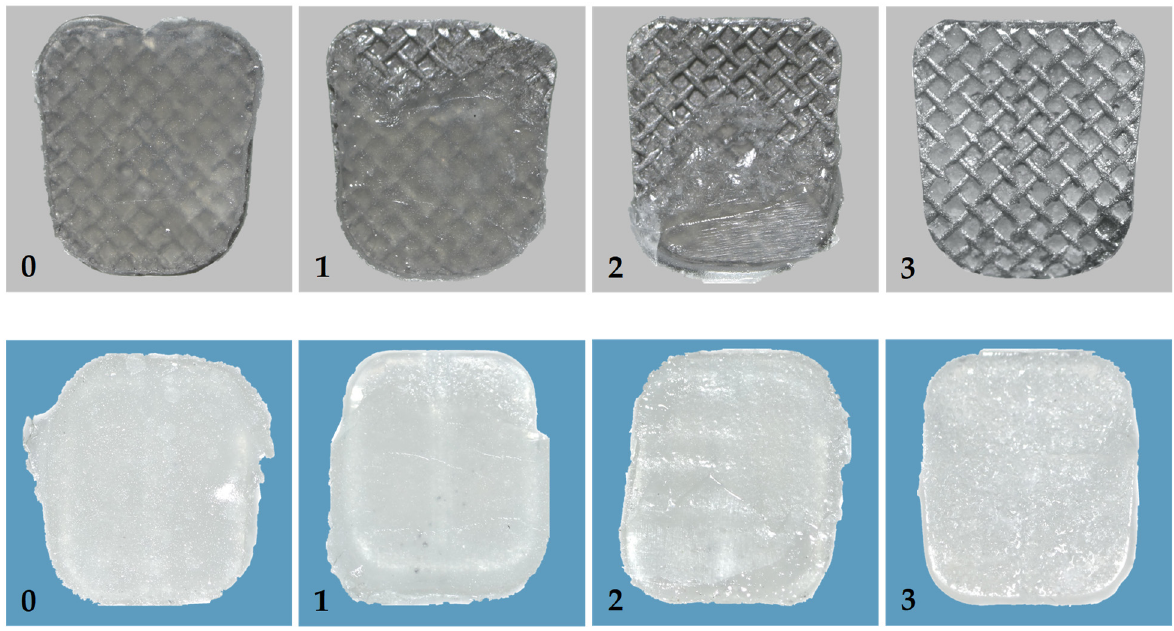
Figure 5. ARI, adhesive remnant index: 0, all adhesive amounts left on the bracket base; 1, ≥ 50% of the adhesive left on the bracket base; 2, <50% of the adhesive left on the bracket base; and 3, no adhesive left on the bracket base. The ( upper ) images show different ARI scores from metal brackets, and the ( lower ) images show different ARI scores from ceramic brackets.